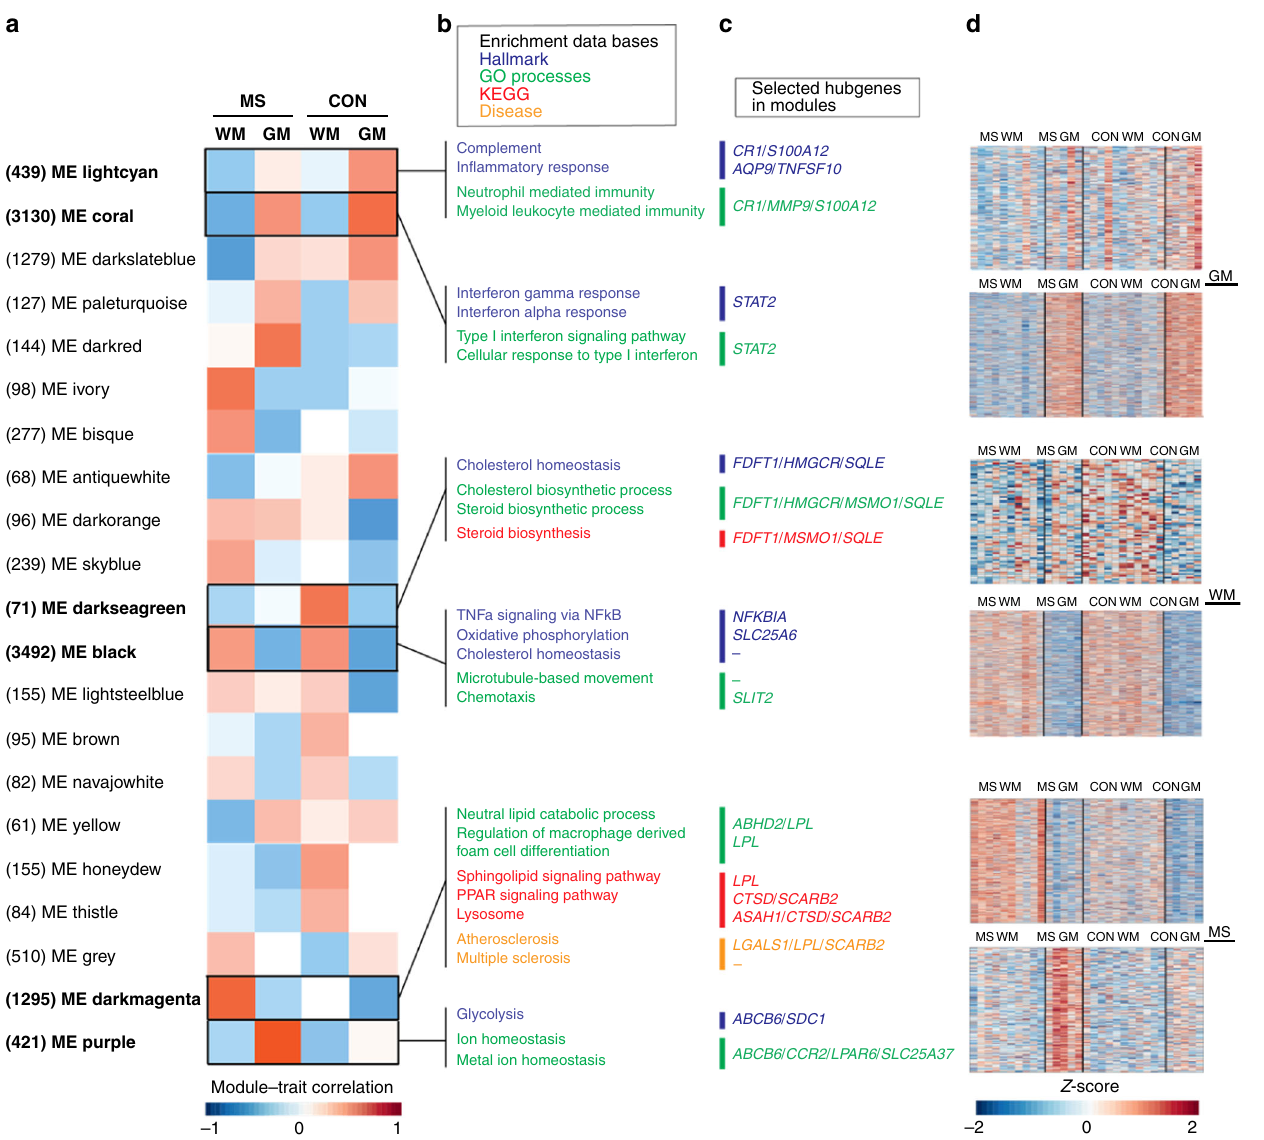
Fig. 3 Co-expression networks for microglia in grey and white matter (GM and WM, respectively) and in normal-appearing multiple sclerosis (MS) tissue. a Twenty-one modules identi fi ed by weighted gene co-expression network analysis are provided with their module – trait correlation and the amount of genes that belong to each module displayed between brackets. b , c Modules of interest for GM and WM regions and for MS GM or WM tissue are highlighted with top enriched hallmarks, Gene ontology terms, Kyoto Encyclopedia of Genes and Genomes pathways, and disease terms as well as top hubgenes with the highest connectivity provided. Module eigengenes (MEs) lightcyan and coral correlate to GM in control or in both control and MS microglia, respectively. MEs darkseagreen and black correlate to WM in control microglia or in both control and MS, respectively. MEs darkmagenta and purple correlate to MS WM or GM, respectively. d Heatmaps display the expression of each gene in modules of interest, based on Z signi fi cantly higher expressed in cortical microglia. In addition, protein expression of signal transducer and activator of transcription factor 2 (STAT2) by microglia in both GM and WM regions was con fi rmed by immunohistochemistry in tissue of control donors (Supplementary Figure 6).